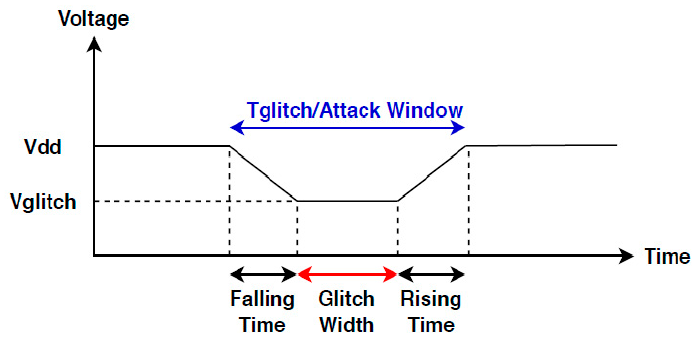
Figure 7. Negative supply voltage glitch.